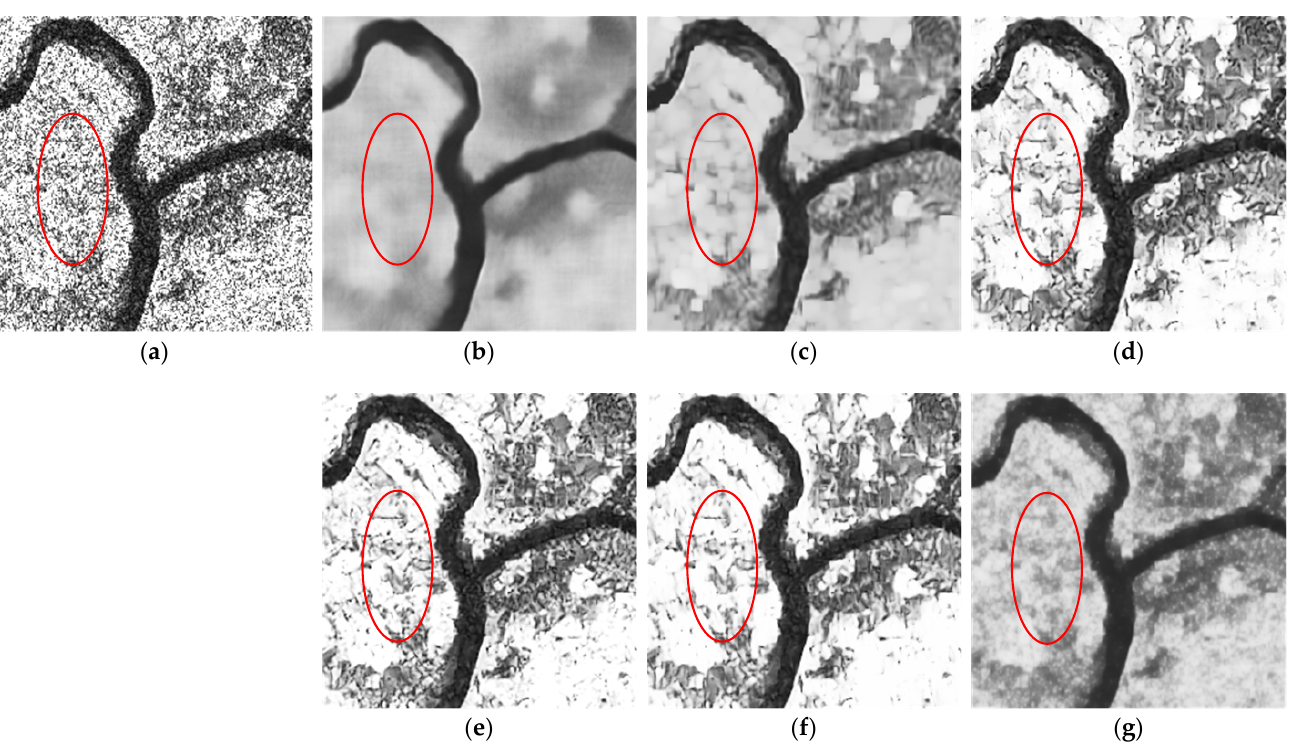
Figure 13. Magnified despeckling results for the TerraSAR-X #1 image. ( a ) Speckled. ( b ) PPB. ( c ) SAR-BM3D. ( d ) ID-CNN.